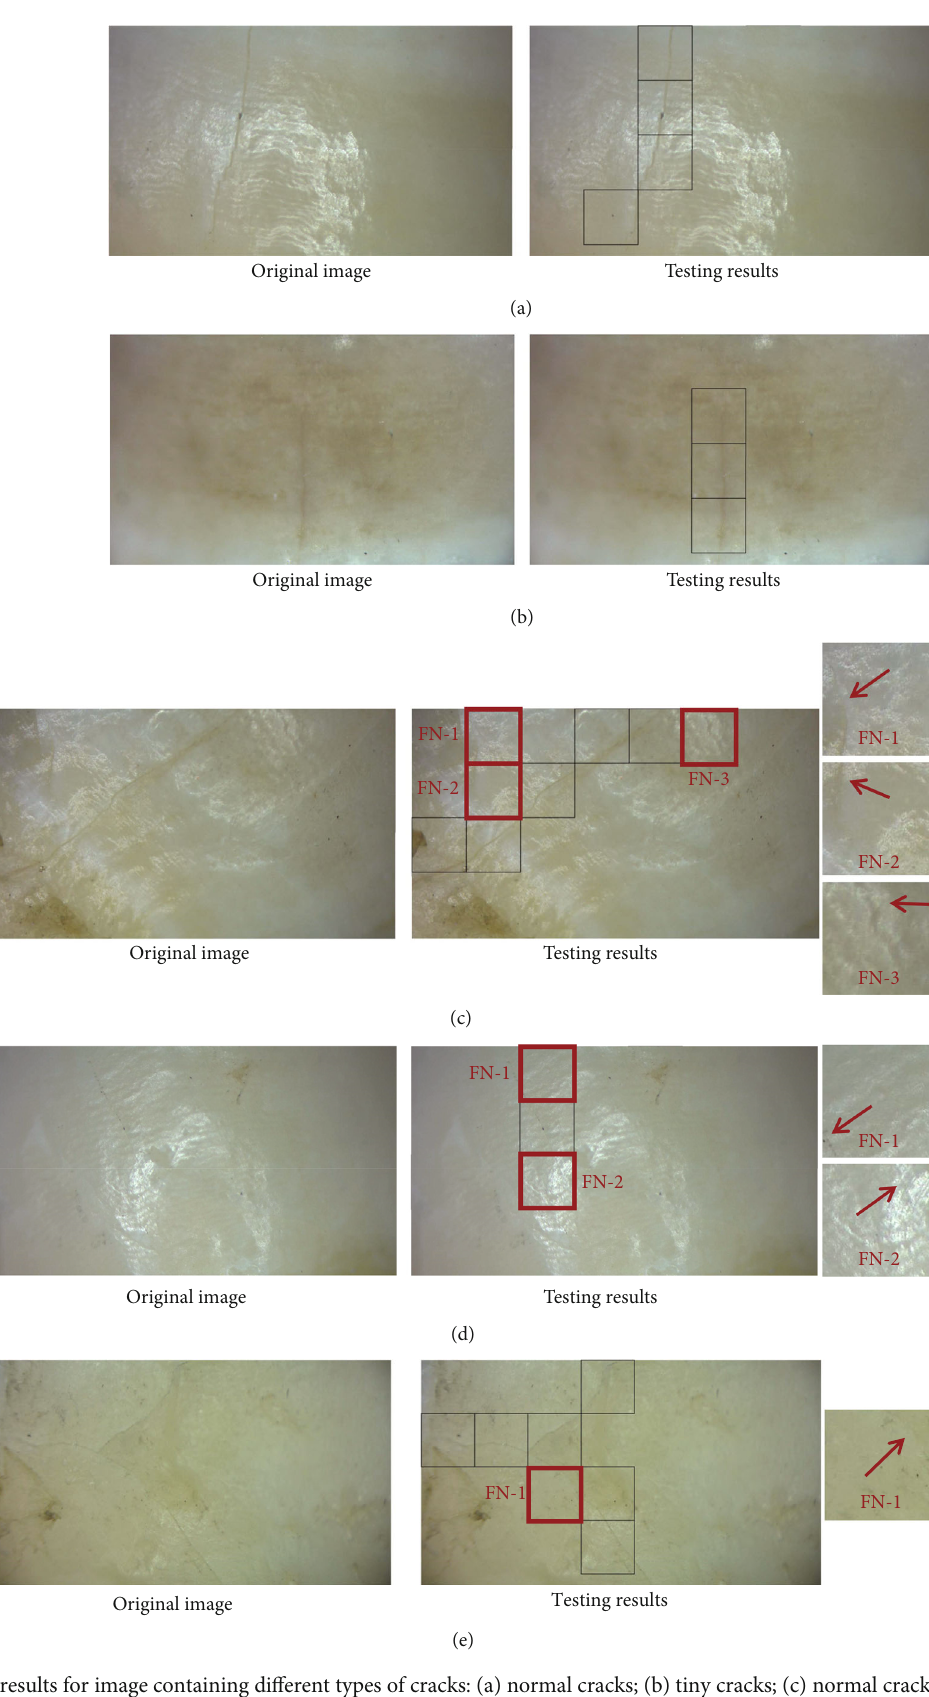
Figure 9: Testing results for image containing di ff erent types of cracks: (a) normal cracks; (b) tiny cracks; (c) normal cracks and thin cracks; (d) tiny cracks and lighting spot; and (e) crossing cracks. The red arrows point to the